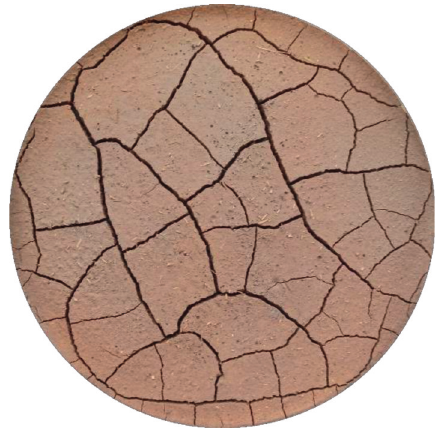
Figure 3: Cracks on the soil surface.